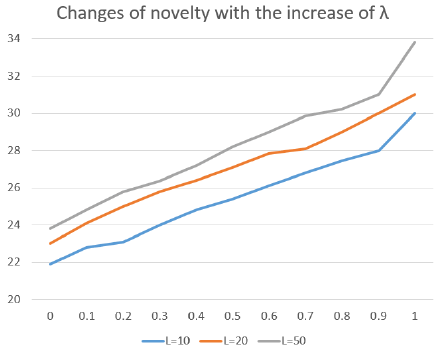
Fig. 8. T he changes of diversification with the increase of λ, Y axis represents diversification and X axis represents λ .